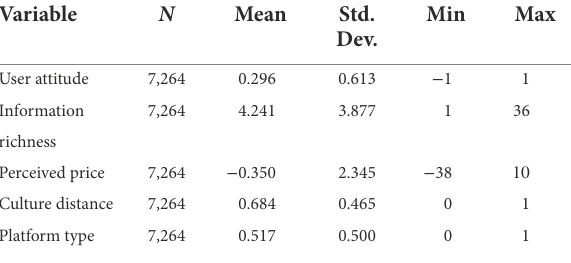
TABLE 1 Demographic